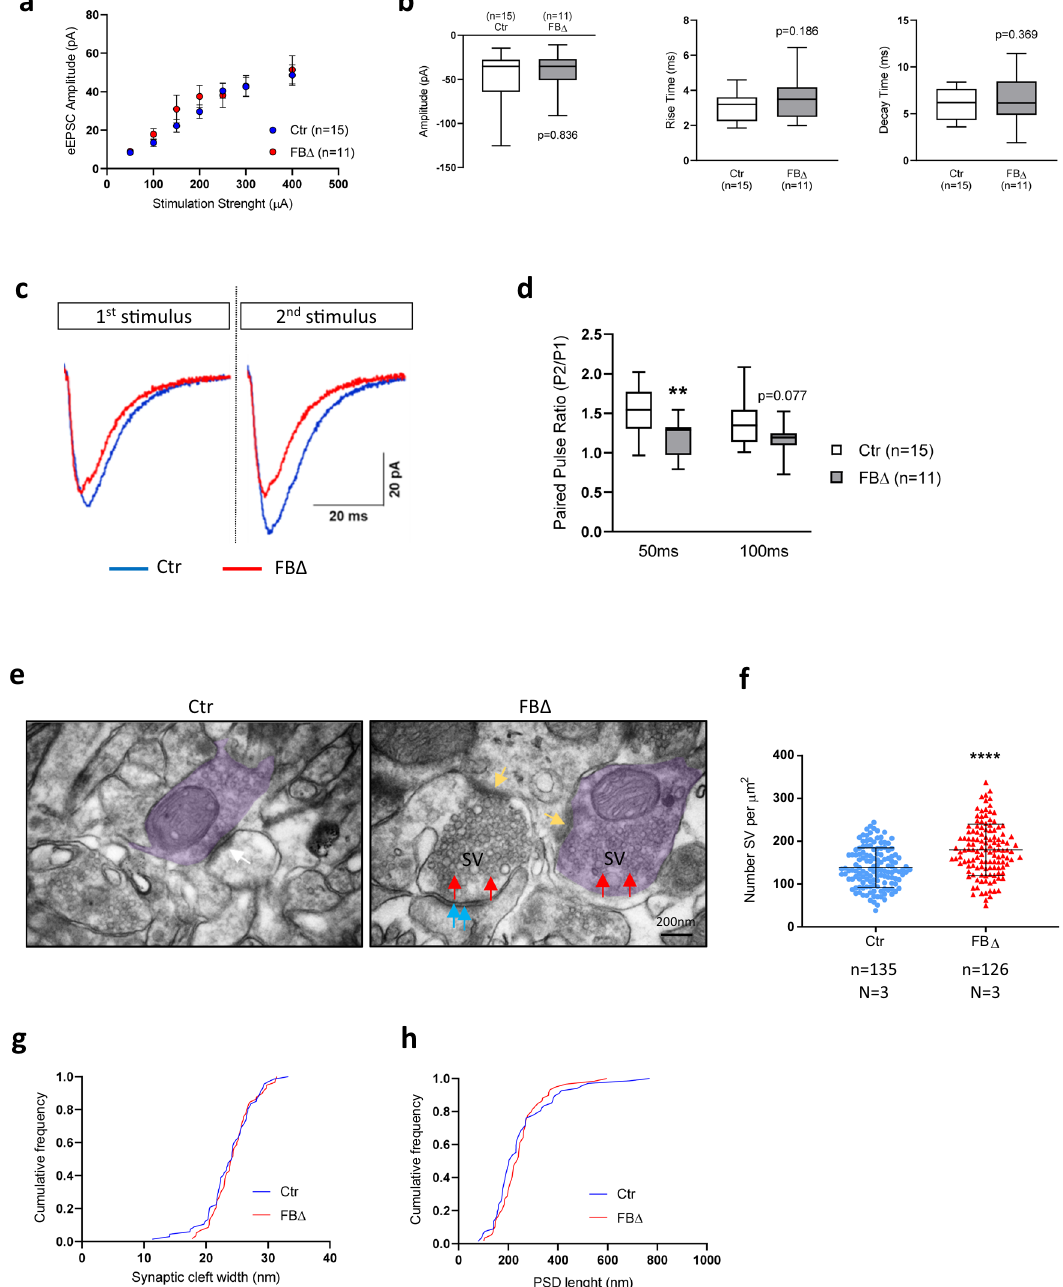
kinetic parameters (Fig. 6a, b) of evoked EPSCs. To test the short- term synaptic plasticity, which depends on presynaptic neuro- transmitter release probability, we measured the paired-pulse facilitation (PPF) of LPP-granule cell (GC) synapses. The paired pulse ratio (PPR) was reduced in both 50 ms ( p = 0.009) and 100 ms (albeit not statistically signi fi cant, p = 0.077) interstimulus intervals in ATR-FB Δ neurons (Fig. 6c, d), indicating an increased neurotransmitter release probability. These results indicate that ATR deletion particularly affects the presynaptic compartment and suggests enhanced vesicle release or vesicle